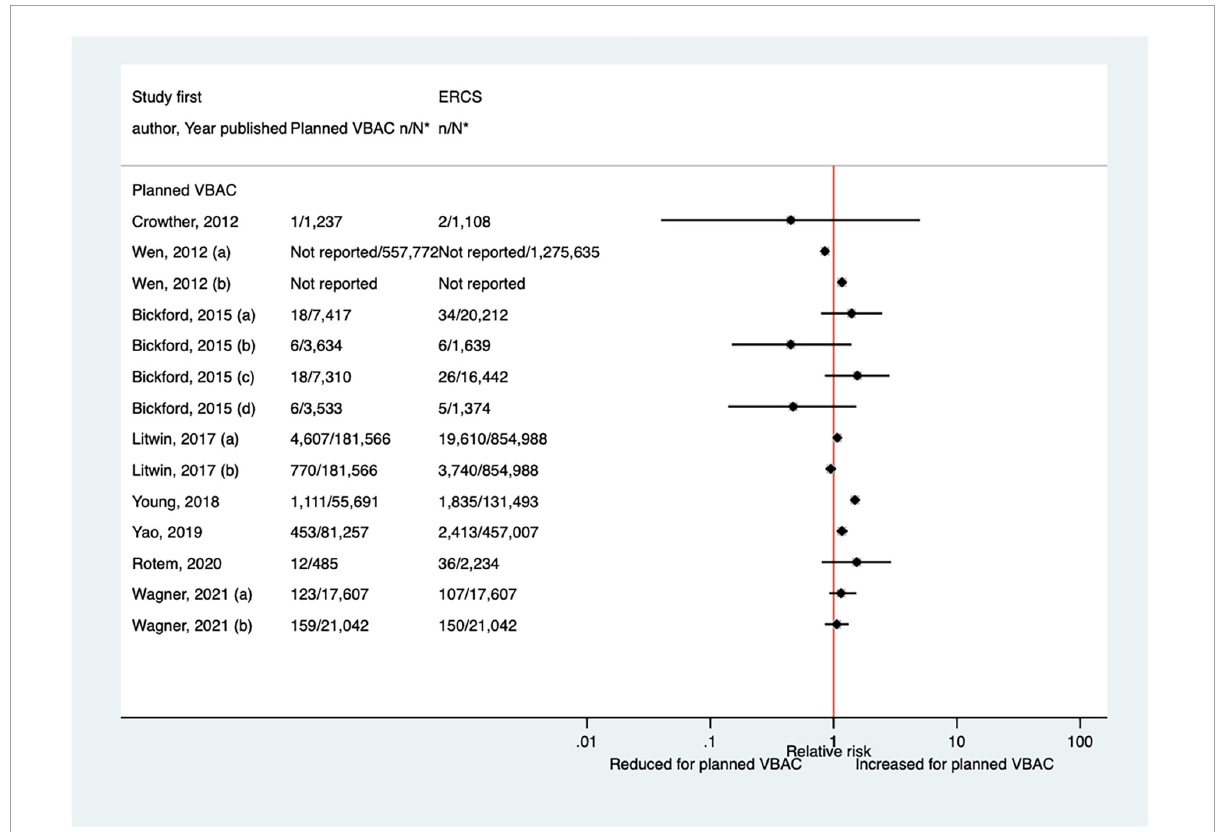
FIGURE9 Risk of neonatal ventilation for planned VBAC vs. ERCS. ∗ n , number in group with the outcome; N , Total number in group. Wen et al. (42) (a) risk in total study population, (b) risk in infants born to “low-risk” women without pre-existing medical problems, pregnancy complications, preterm birth or an infant with low birth weight or congenital anomaly. Bickford and Janssen (50) (a) risk in women with 1–2 prior CSs only, (b) risk in women with 1–2 prior CSs and ≥ 1 prior VB, (c) risk in women with 1 prior CS only, (d) risk in women with 1 prior CS and ≥ 1 prior VB. Litwin et al. (59) (a) outcome: assisted ventilation, (b) outcome: assisted ventilation > 6 h. Wagner et al. (77) (a) Risk in women with no prior vaginal births. (b) Risk in women with ≥ 1 prior vaginal birth. CS, cesarean section; ERCS, elective repeat cesarean section; VBAC, vaginal birth after previous cesarean; VB, vaginal